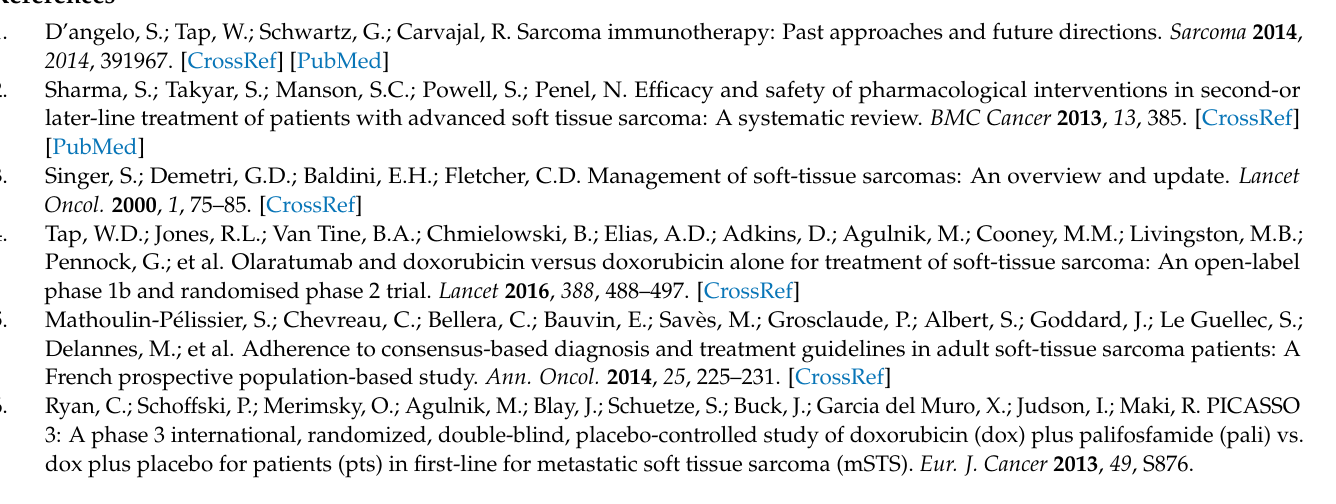
Table S2. Clinical data of TCGA-SARC cohort. Table S3. RNA sequence data of normal soft tissues. Table S4. RNA sequence data of GSE63157 and GSE30929. Table S5. Survival data from GSE63157 Table S8. 64 types of TME